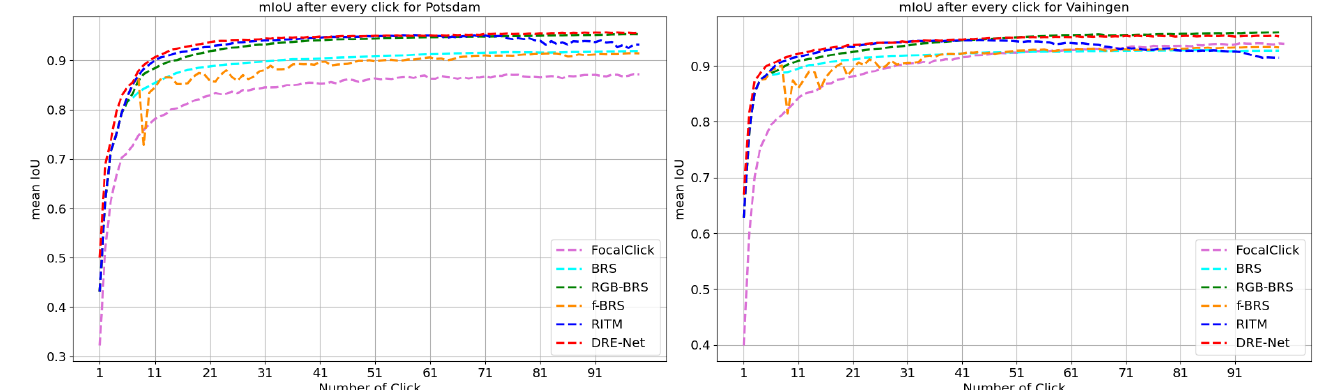
Figure 12. Comparison of the CG on the surface category in the Potsdam and Vaihingen datasets. A smoothly rising curve shows better CG